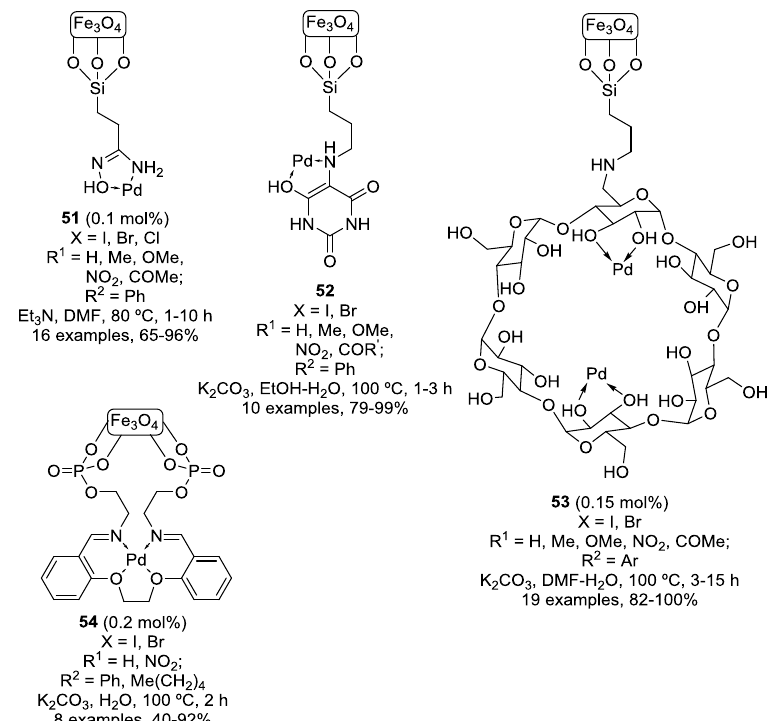
Figure 17. Magnetite grafted palladium catalysts for the Sonogashira reaction. Conditions, substrate scope and yield range (Scheme 2).